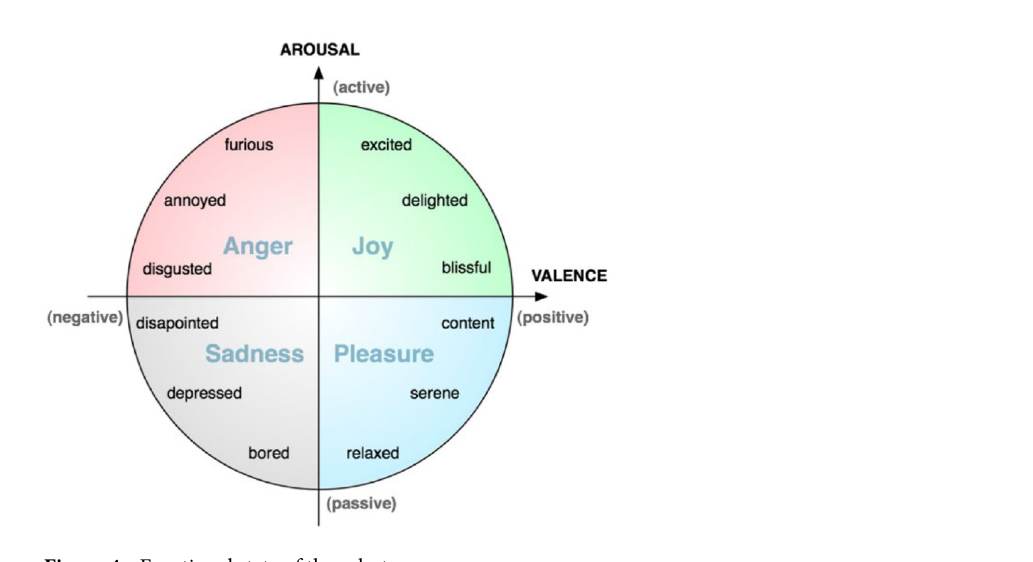
Figure 4. Emotional state of the